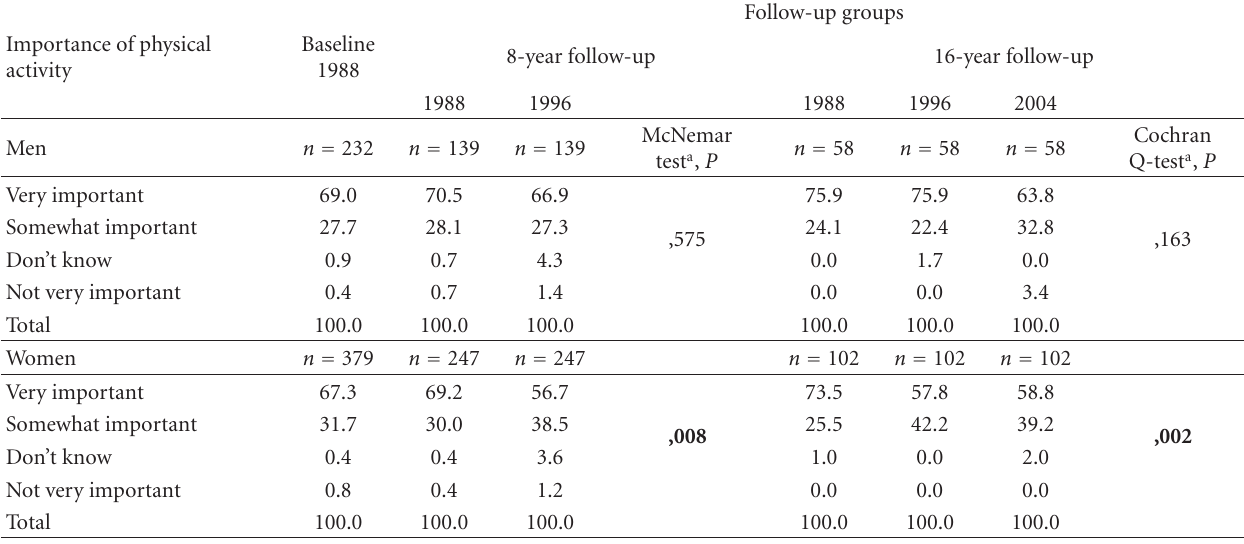
Table 3: The importance of physical activity among men and women aged 65–74 years at baseline and in 8- and 16-year follow-up studies, (%, P